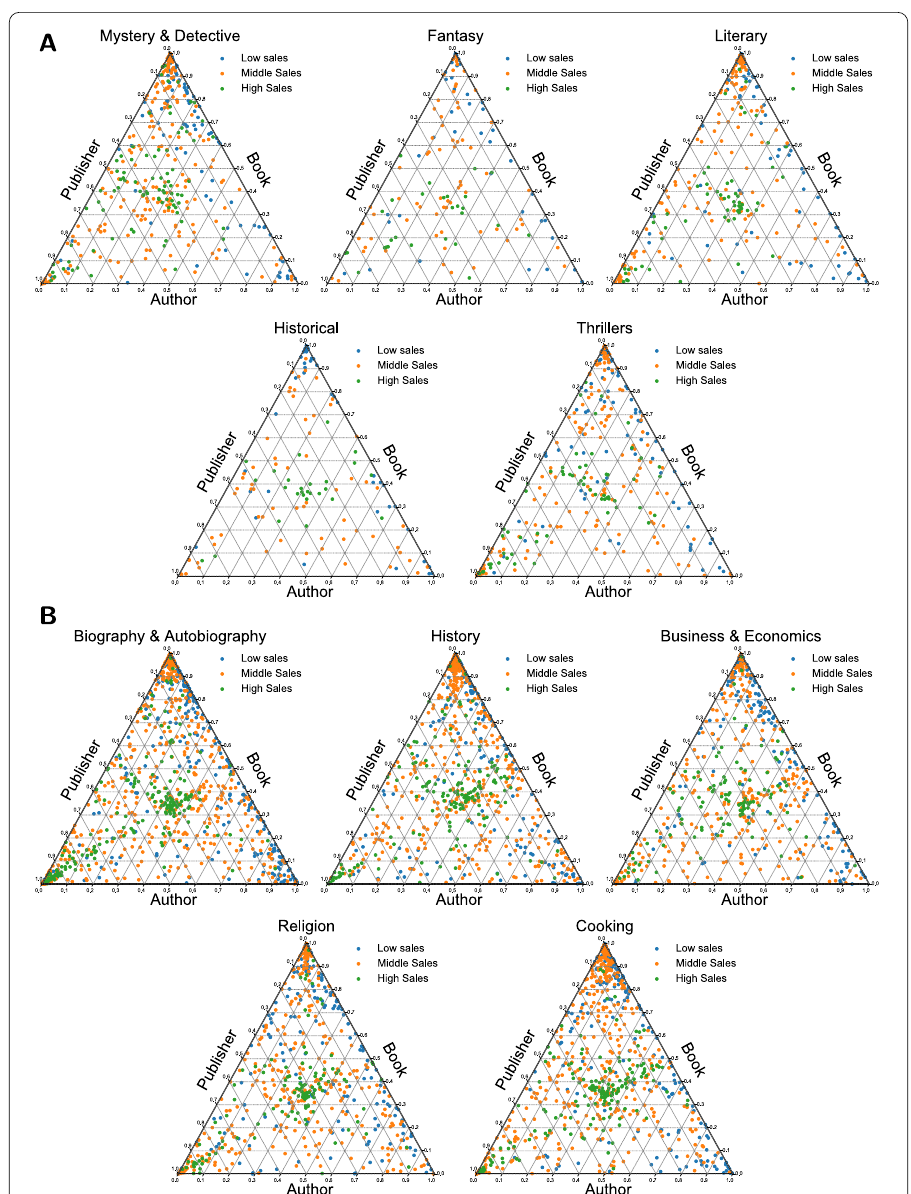
Figure 10 Ternary scatter plot of normalized absolute error for feature group importance for different genres. For each dot, the three values are the normalized absolute error generated by LearningtoPlace with only the corresponding feature group. We color each book based on the actual sale category of that book, where low is the lower 30th percentile, middle is between 30th to 80th percentile and high is the top 20th percentile. For all ternary plots of ( A ) fiction genres and ( B ) nonfiction genres, the densest area is the top corner, meaning that with only book feature the model generates the highest error for those books, implying author and publisher information are very important. The second densest area is the left corner, meaning that publisher feature is not sufficient for accurate prediction. The third densest area is the middle of the triangle. Interestingly, we see that most dots in the middle area are books with high sales, meaning that for high-selling books, the importance of three feature groups are rather balanced